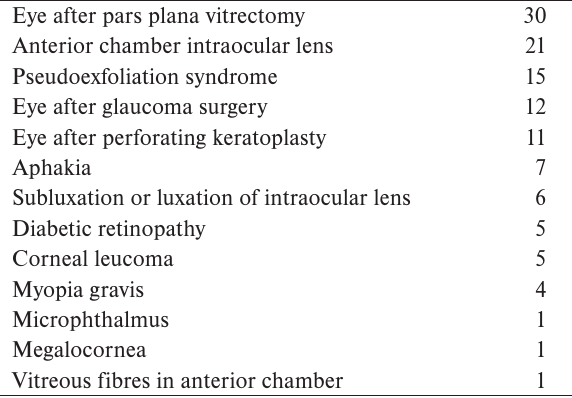
Table 1. Overview of types and rates of ocular pathologies in Group 1.